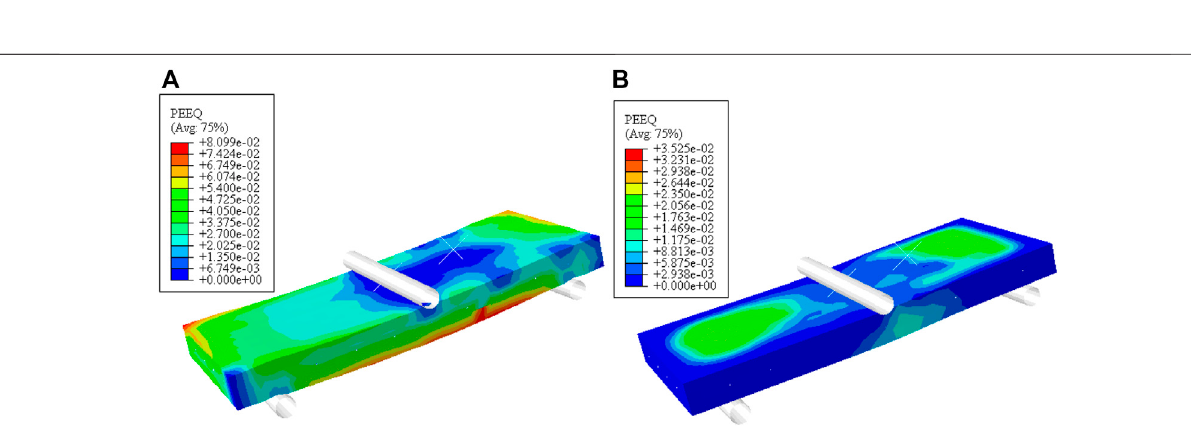
Frontiers in Earth Science |